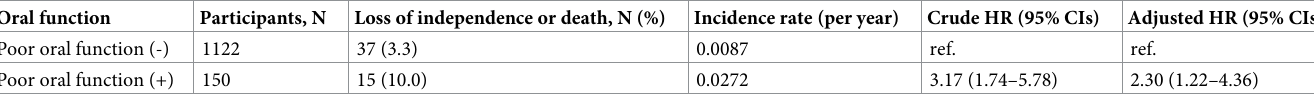
Table 2. Association between poor oral function and loss of independence or death.